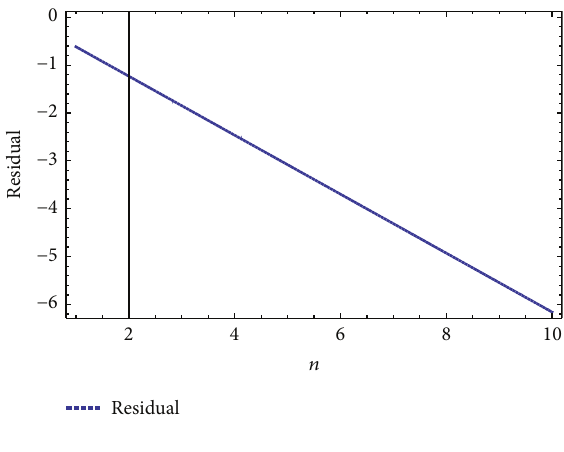
Figure 2: Residual of (19) at 𝑡 = 1